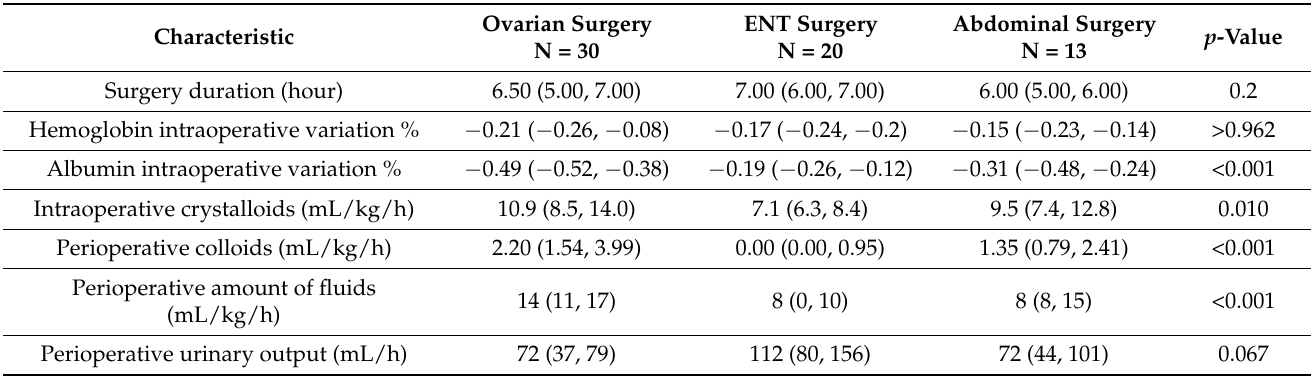
Table 2. Intraoperative characteristics with regard to type of